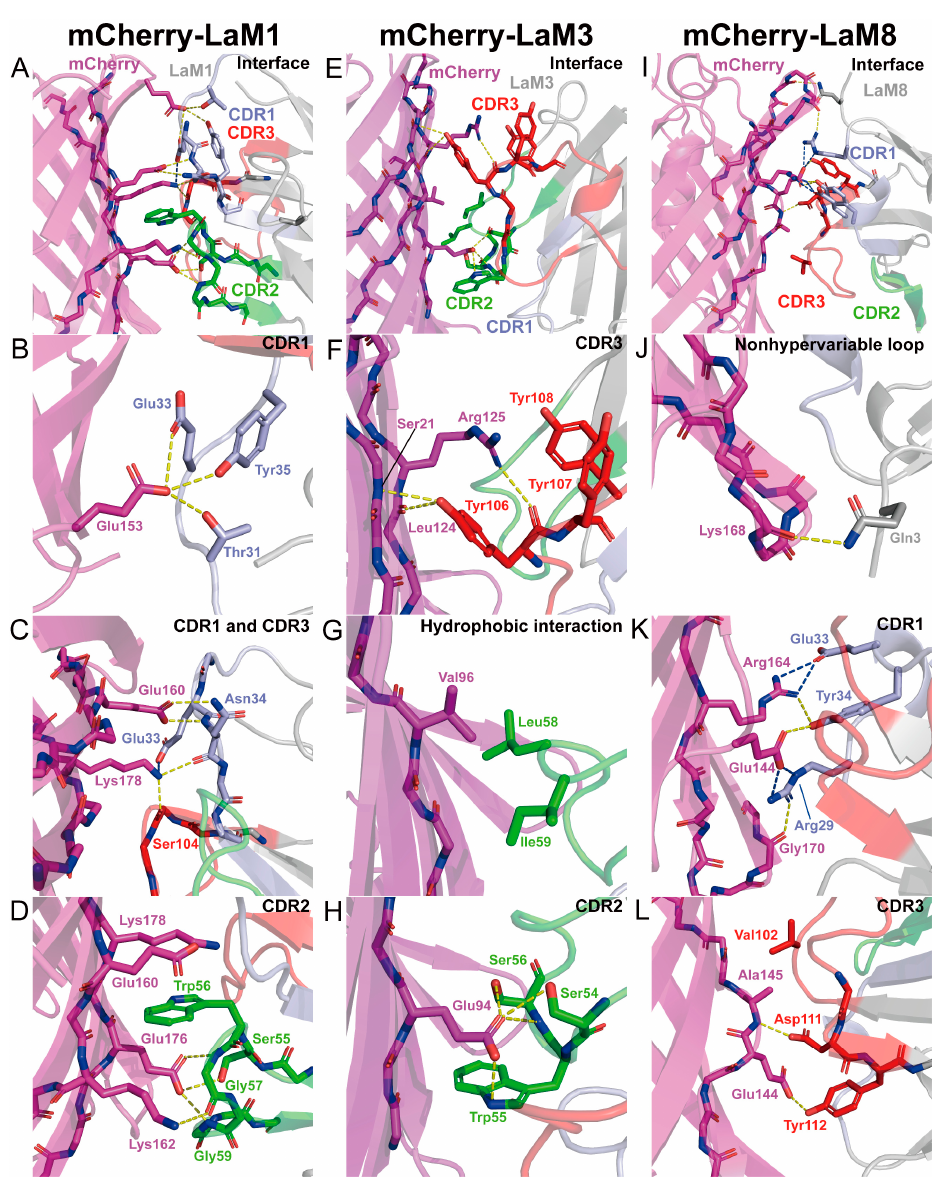
Figure 2. Interaction surface between mCherry and LaM nanobodies in the crystal structure of mCherry-LaM nanobody complexes. ( A , E , I ) show overviews of the interface for mCherry-LaM1, mCherry-LaM3, and mCherry-LaM8, respectively. The mCherry is colored pink and LaM nanobodies in grey, the CDR1, CDR2, and CDR3 of LaM nanobodies are colored in light blue, green, and red, respectively. Panels ( B – D ), ( F – H ), and ( J – L ) show detailed interactions between LaM1 and mCherry, LaM3 and mCherry, and LaM8 and mCherry, respectively. Hydrogen bonds are shown in yellow dashes, salt bonds are shown in blue dashes, and key residues are depicted as sticks.